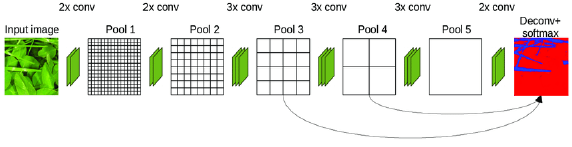
Figure 1. FCN-8s architecture (Skovsen et al.,